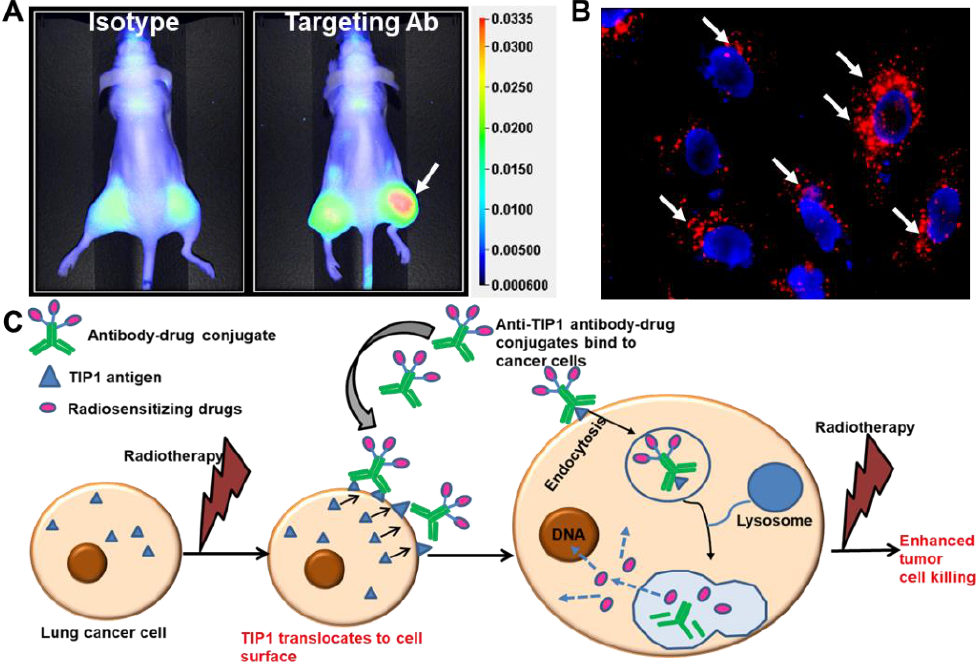
Figure 4. Radiation-sensitizing antibody–drug conjugates. ( A ) Near-infrared (NIR) imaging showing specific binding of the antibody targeting a radiation-inducible antigen to irradiated tumors (white arrow). Nude mice were injected subcutaneously with A549 cells. The right hind limb tumors were irradiated with three doses of 3 Gy. Isotype control or targeting antibody was injected via tail vein, and NIR imaging was performed to evaluate the biodistribution of the antibody (Adapted from [3]). ( B ) Endocytosis of ADC in cancer cells. The cancer-specific antibody was labeled with pH-sensitive dye pHrodo and incubated with cancer cells. Punctate red fluorescence indicates accumulation of the antibody in acidic compartments of the cells (white arrows). Nuclei are stained blue. ( C ) Schematic representation of the strategy to enhance the therapeutic efficacy of radiation and reduce detrimental side effects. Radiation enhances surface expression of radiation inducible antigens such as TIP1 in lung cancer and not normal cells, leading to specific binding of ADCs to cancer. ADCs deliver radiosensitizers to cancer. Radiotherapy then leads to enhanced cancer cell killing without effecting normal cells.